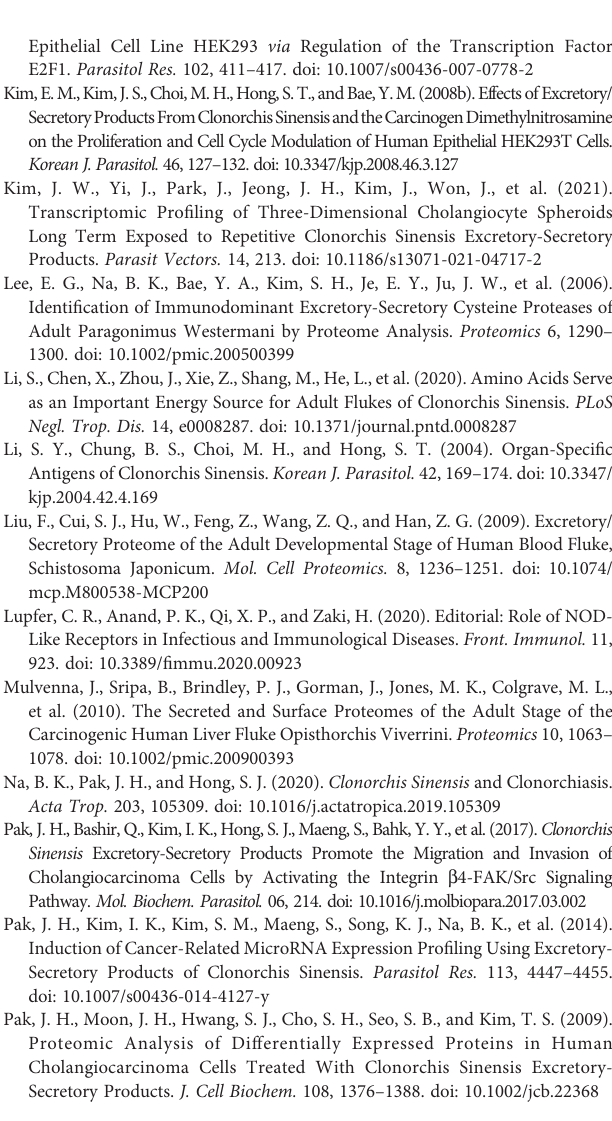
Supplementary Figure 1 | Mass spectrometry analysis of the ESP components. (A) SDS-PAGE analysis of the total ESPs of C. sinensis . (B) Comparative analysis between the identi fi ed proteins and C. sinensis protein library. Supplementary Figure 2 | Domains and interacting proteins prediction of myoferlin. (A) The domains predetermination of myoferlin. (B) The protein network interaction predetermination of